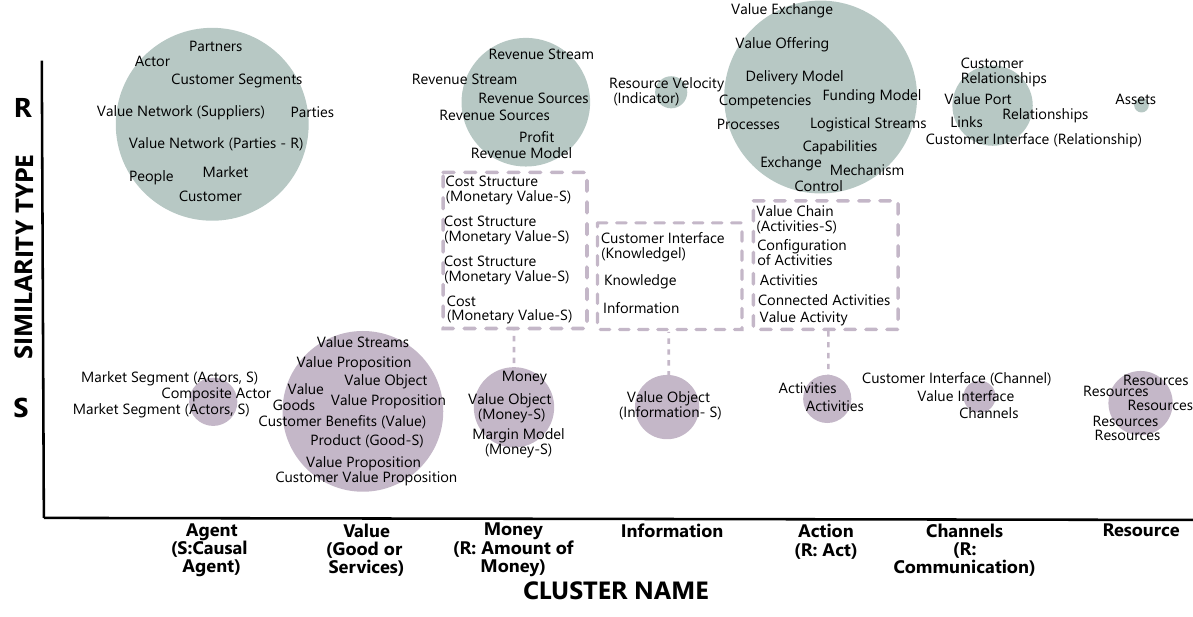
Figure 5. Concept